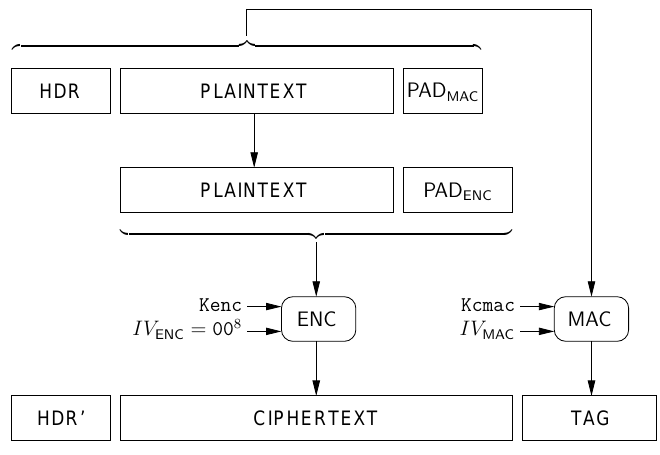
Figure 1: Encryption and MAC computation of a command data with